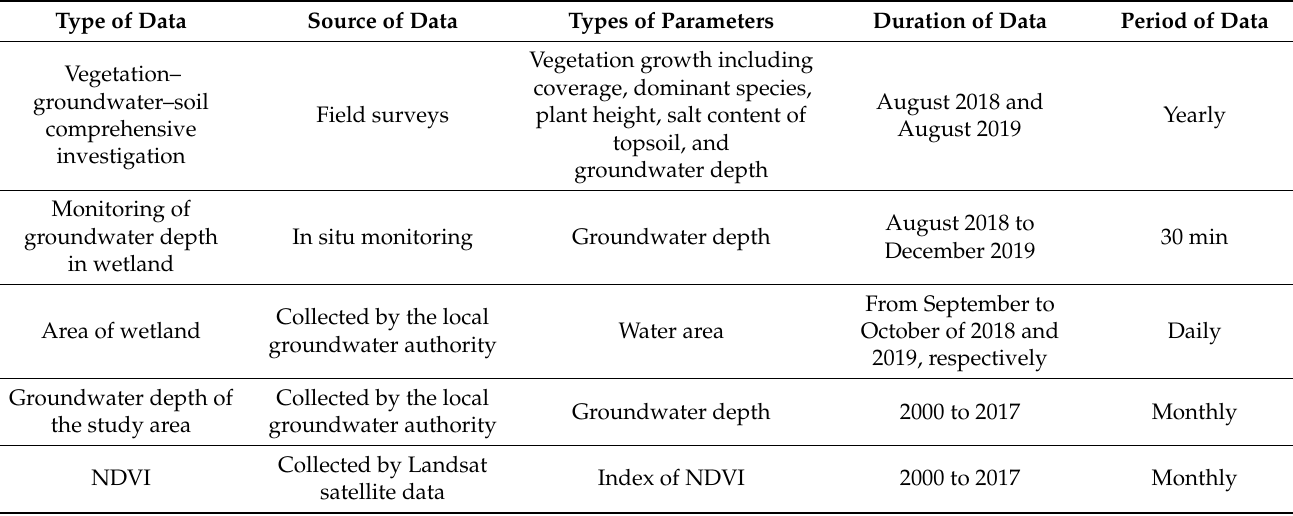
Table 1. Data description of field investigation and